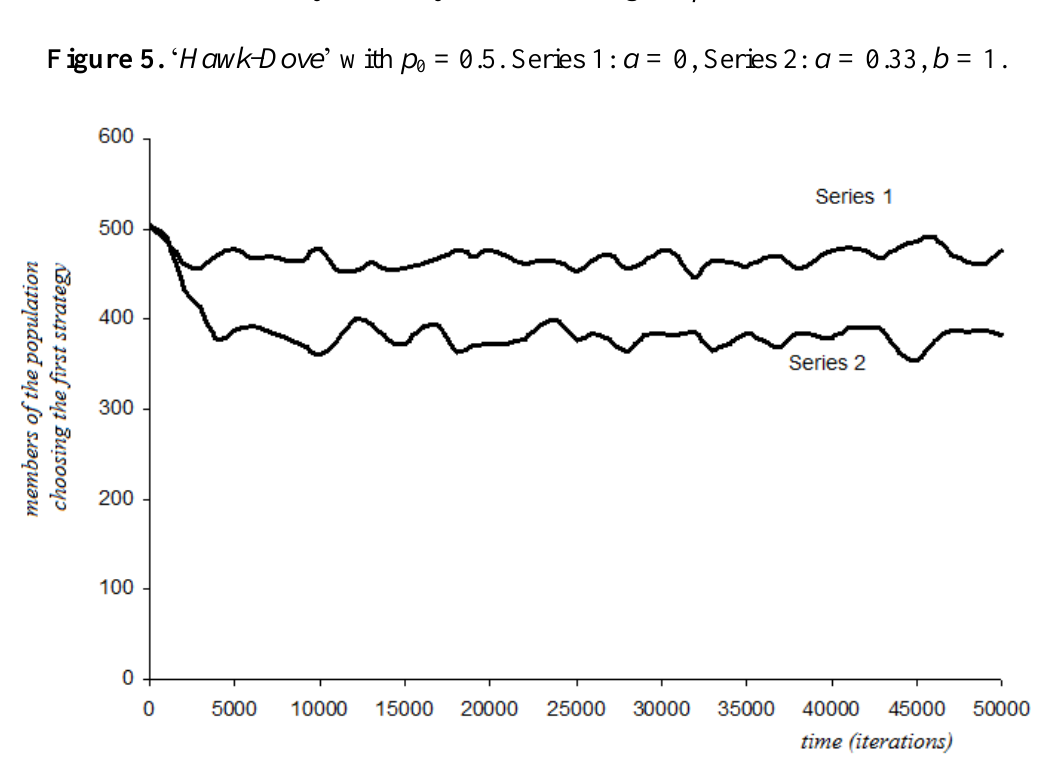
Figure 5. ‘ Hawk-Dove ’ with p